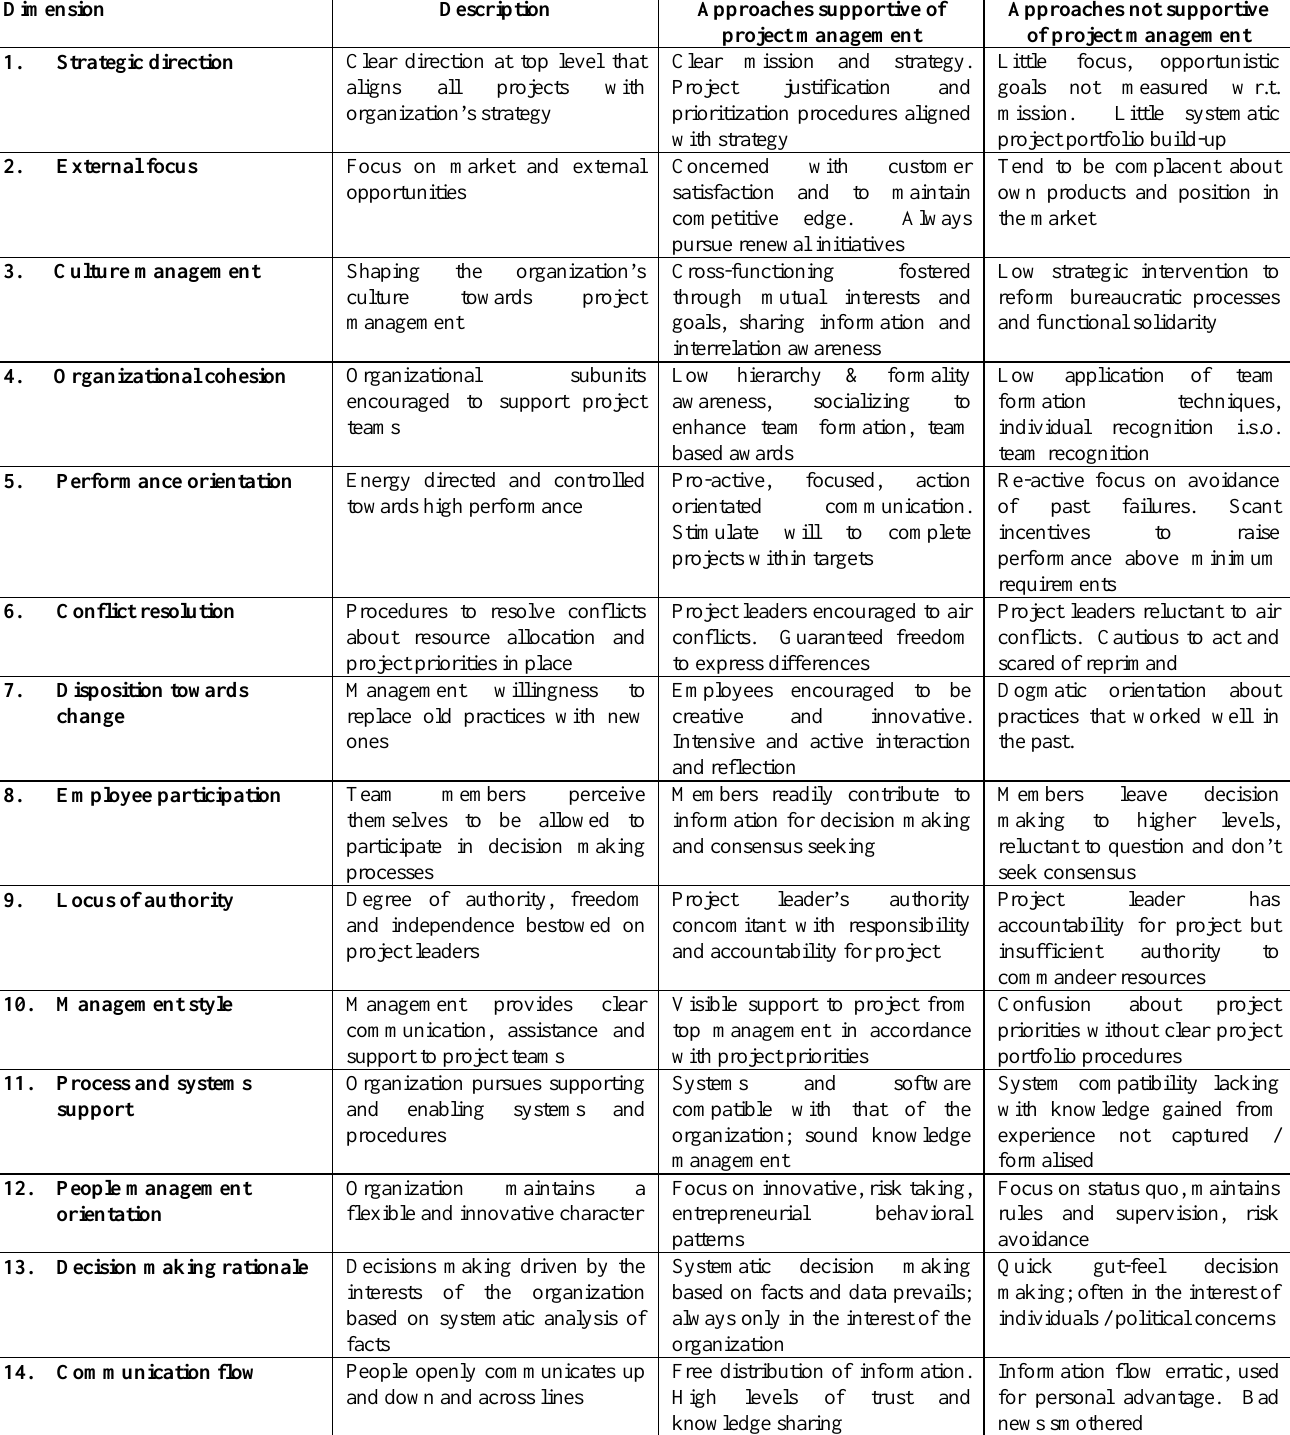
Table 1: Cultural diagnostic, containing 14 dimensions of organizational culture supportive of project management